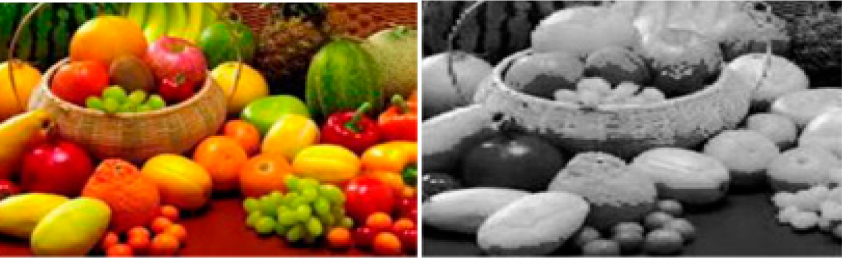
Figure 7. Region-Based Segmentation [50].